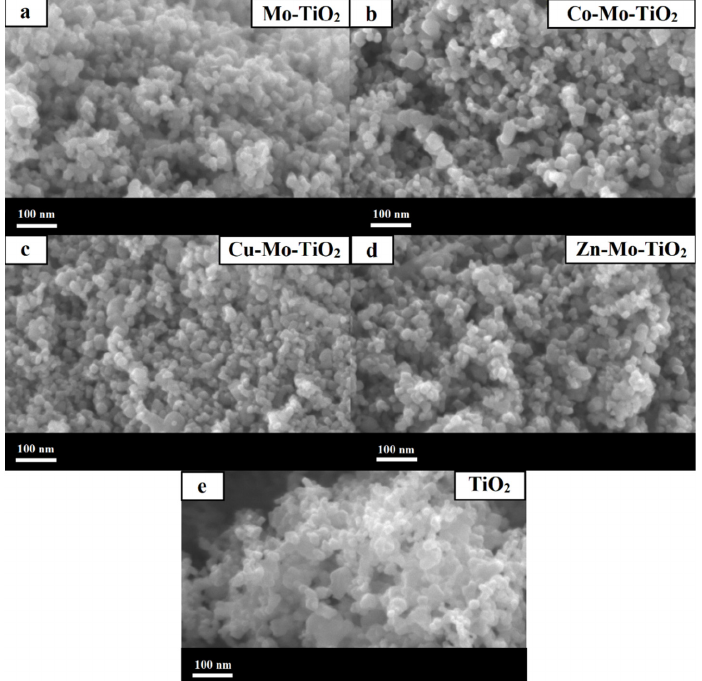
Figure 6. SEM images of ( a ) Mo ‐ TiO 2 , ( b ) Co ‐ Mo ‐ TiO 2 , ( c ) Cu ‐ Mo ‐ TiO 2 , ( d ) Zn ‐ Mo ‐ TiO 2 , and ( e ) TiO 2 .